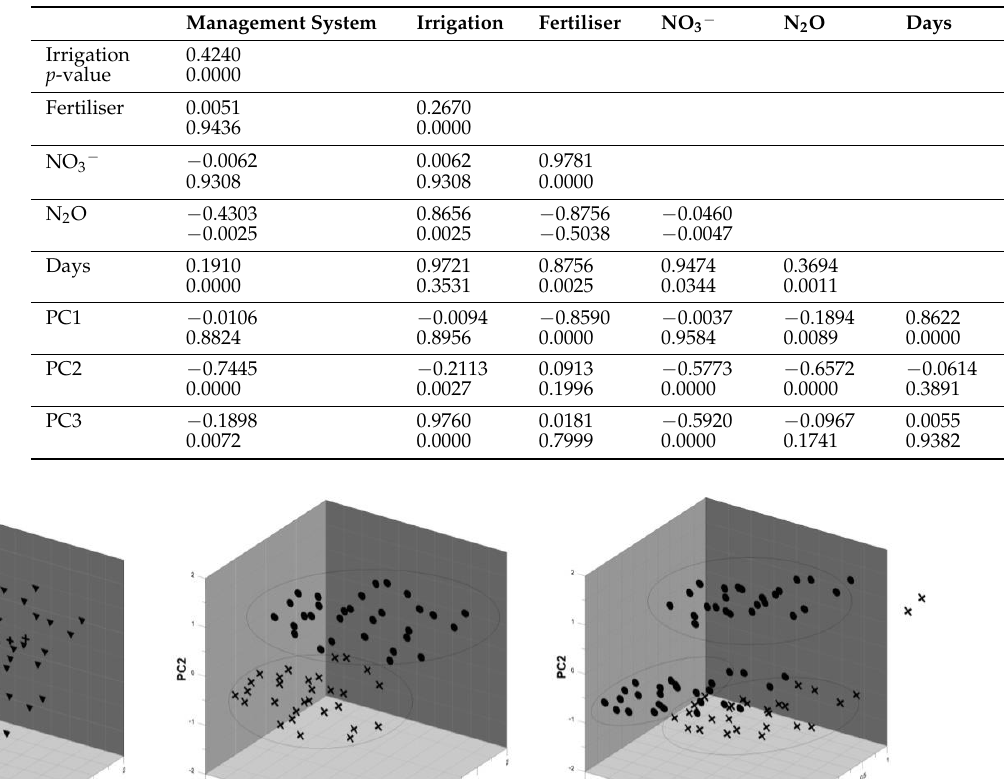
Table 7. Correlation matrix of the studied variables.